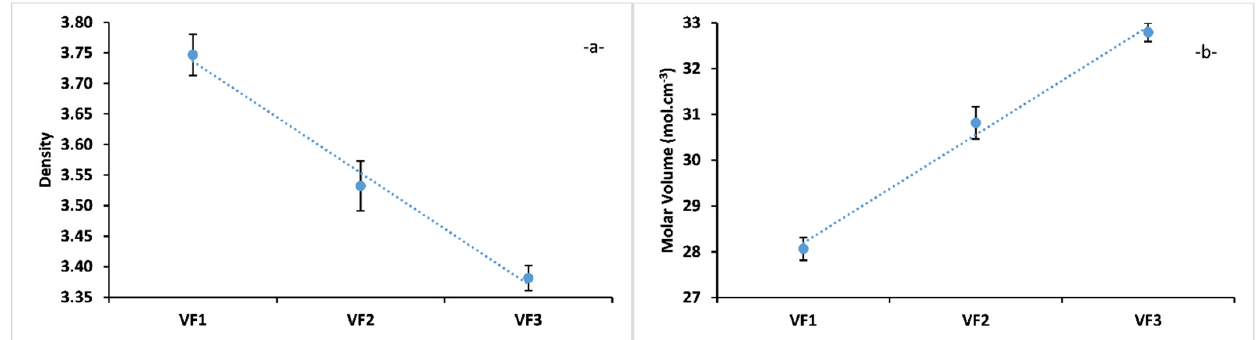
Figure 2. Density ( a ) and Molar Volume ( b ) for concentrations of [K 2 O/(CaO+MgO)] ratio (%mol). VF1: 0.67 %mol, VF2: 1.33 %mol and VF3: 2 %mol.